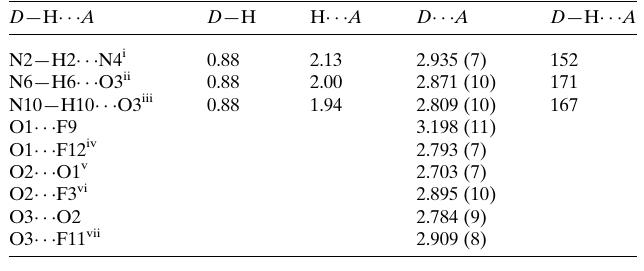
Table 1 Hydrogen-bond geometry (A˚ , (cid:3)